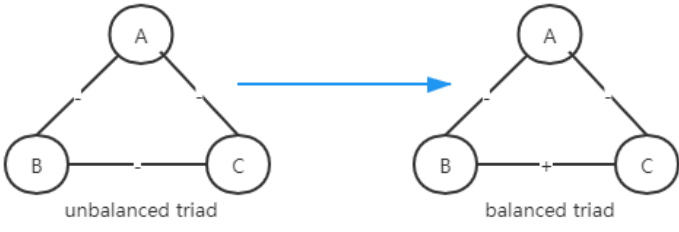
Figure 18. Negative edge changes: the edge between nodes B and C evolves from − 1 to +